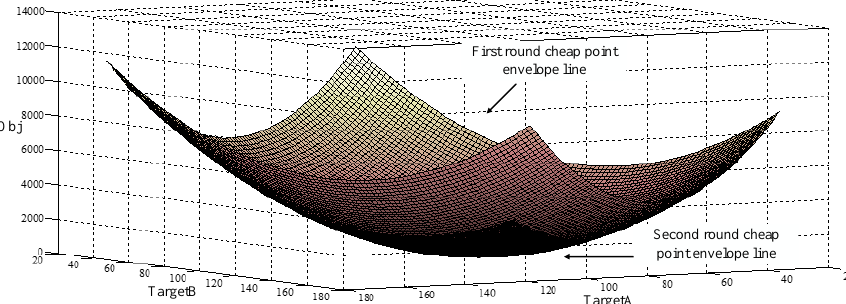
Figure 14. Two rounds sampling points’ envelope lines.